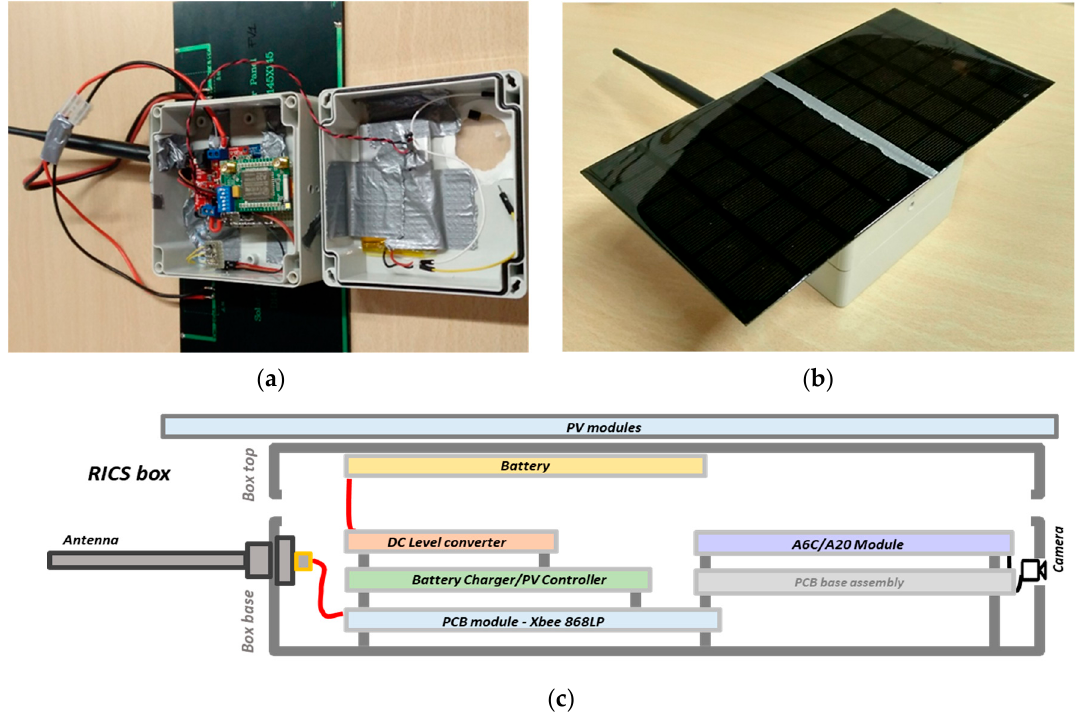
Figure 4. Sample view and diagram of the RICS box. ( a ) Assembly of the prototype RICS node. ( b ) The same prototype with the box closed, showing the two photovoltaic modules and the position of the antenna. ( c ) Diagram of the elements in a stacked mount: XBee 868LP, a battery charger/photovoltaic module controller, A20 module and the Li-ion battery in the top of the enclosure.